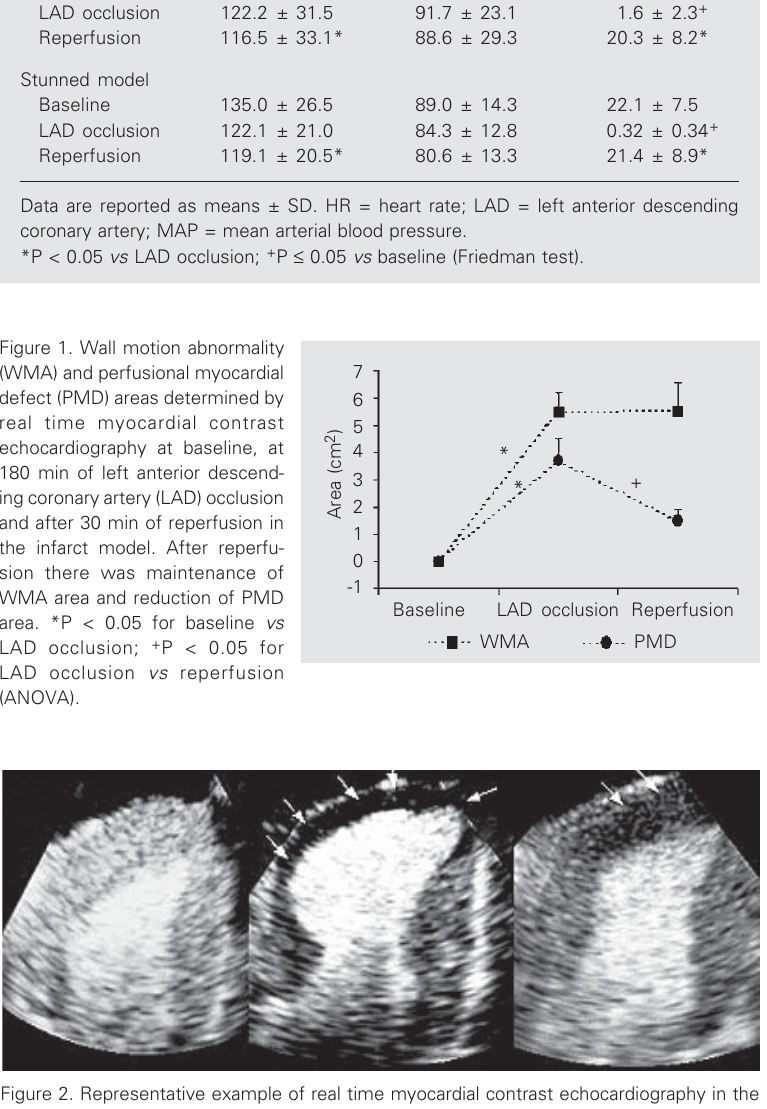
1. Hemodynamic data for the experimental dogs submitted to infarct or stun- ning. HR (bpm) MAP (mmHg) LAD flow (ml/min) Infarct model